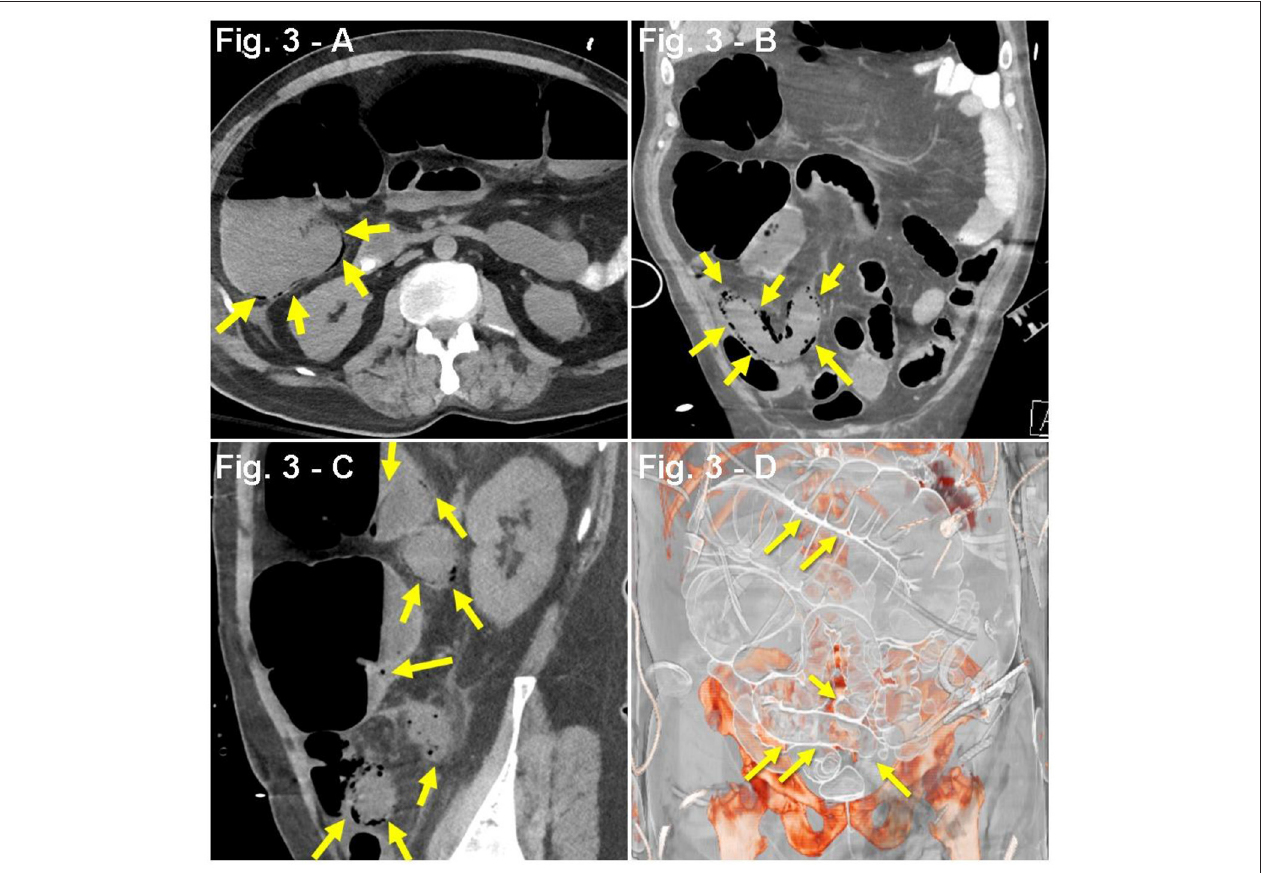
FIGURE 3 | (A–D) Case presentation of a 63-year-old male patient, with dyspnea, cough, fever from COVID-19, with bloody diarrhea, and abdominal distention 3 days after receiving TCZ, abdominal CT with oral contrast only, (A) axial, (B) coronal, (C) sagittal, and (D) 3D reconstruction with consolidation seen along lung bases, and pneumatosis of small bowel loops (yellow arrows) with dilated small and large bowel loops consistent with